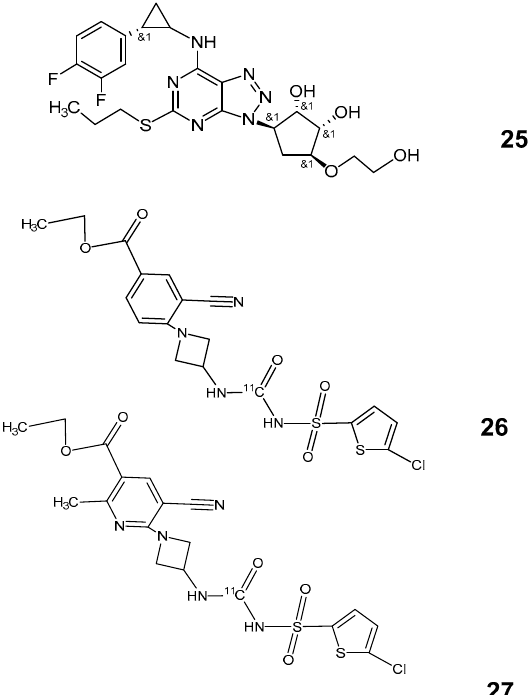
Figure 6. P2Y12 antagonists: 25 : AZD6140; 26 : C2; 27 : C5.